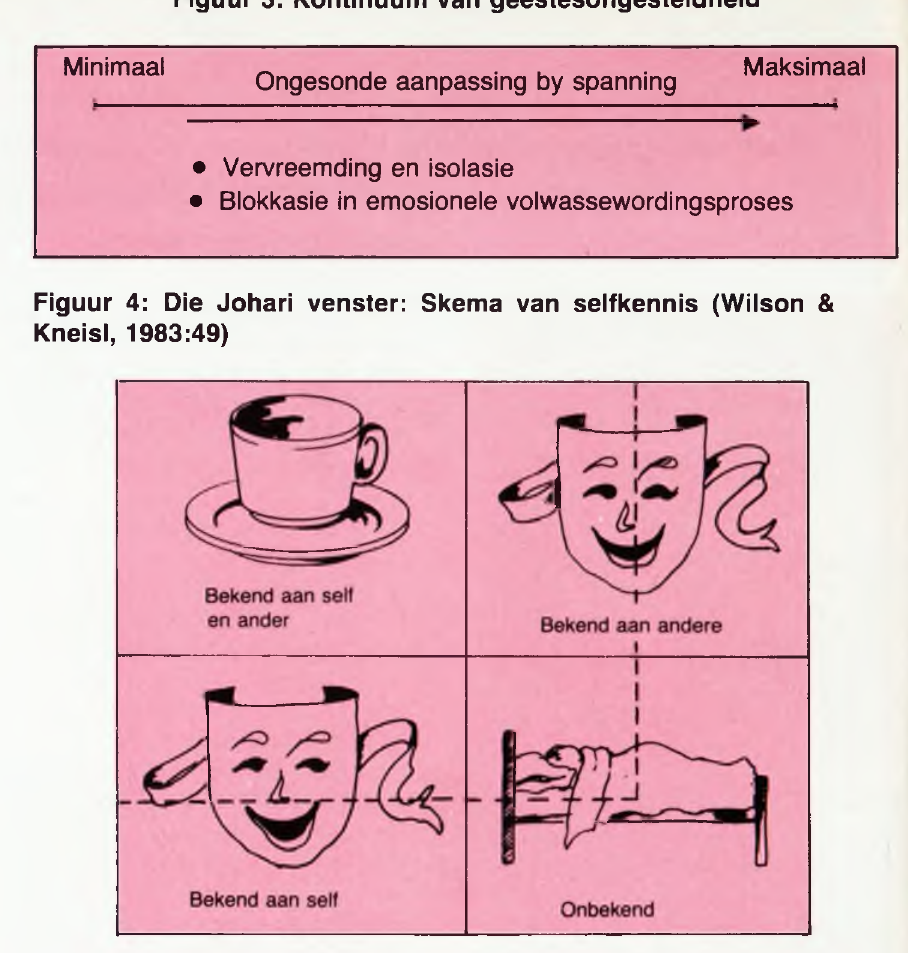
Figuur 3: Kontinuum van geestesongesteldheid